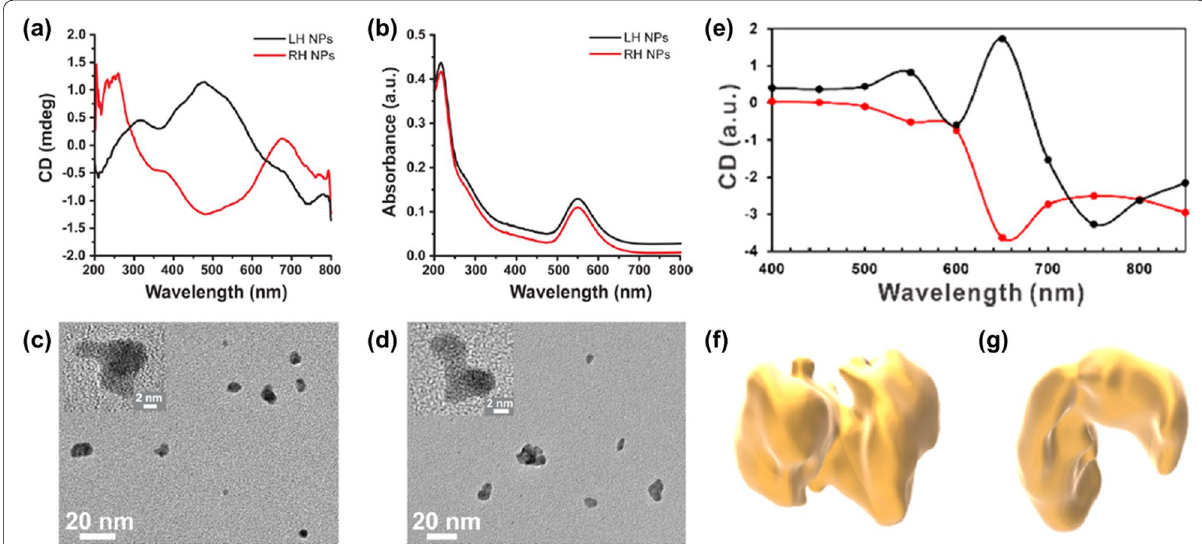
Fig. 16 a CD spectra and b UV–vis absorbance spectra of dispersions formed under LCP (LH NP, black) and RCP (RH NP, red) ( c , d ) High resolution TEM images of NPs obtained with c LCP and d RCP illumination. e Calculated CD spectra with geometry of particle imported directly from tomographic reconstruction. f , g Experimentally obtained tomographic reconstructions of f LH and g RH gold nanostructures. Reproduced with permission from [18]. Copyright American Chemical Society,